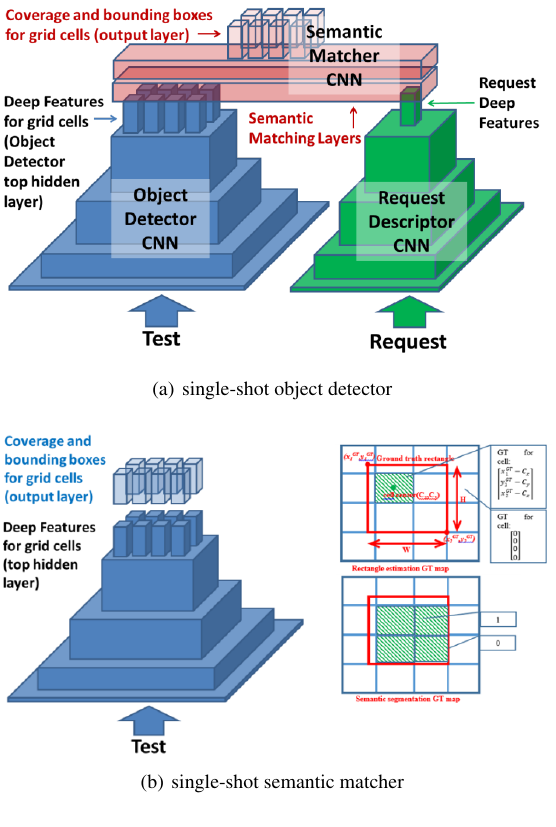
Figure 2. From single-shot object detector (a) to our single-shot semantic matcher CNN architecture